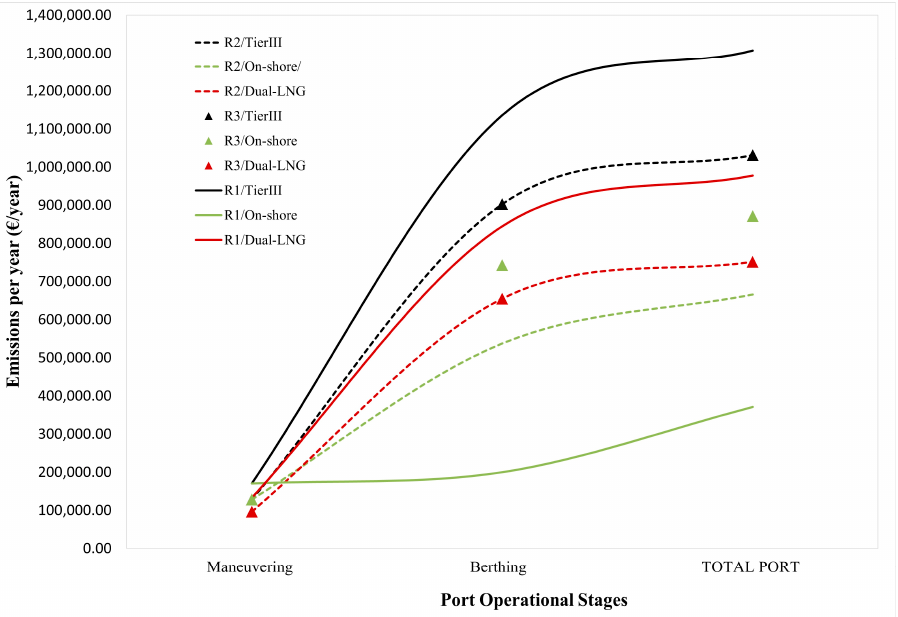
Figure 2. Emissions per year of feeder vessels in port. R1: Vigo (Spain)–St. Nazaire (France) R2: Las Palmas (Gran Canaria island)–Huelva (Spain) R3: Las Palmas (Gran Canaria island–Sta. Cruz de Tenerife (Tenerife island).